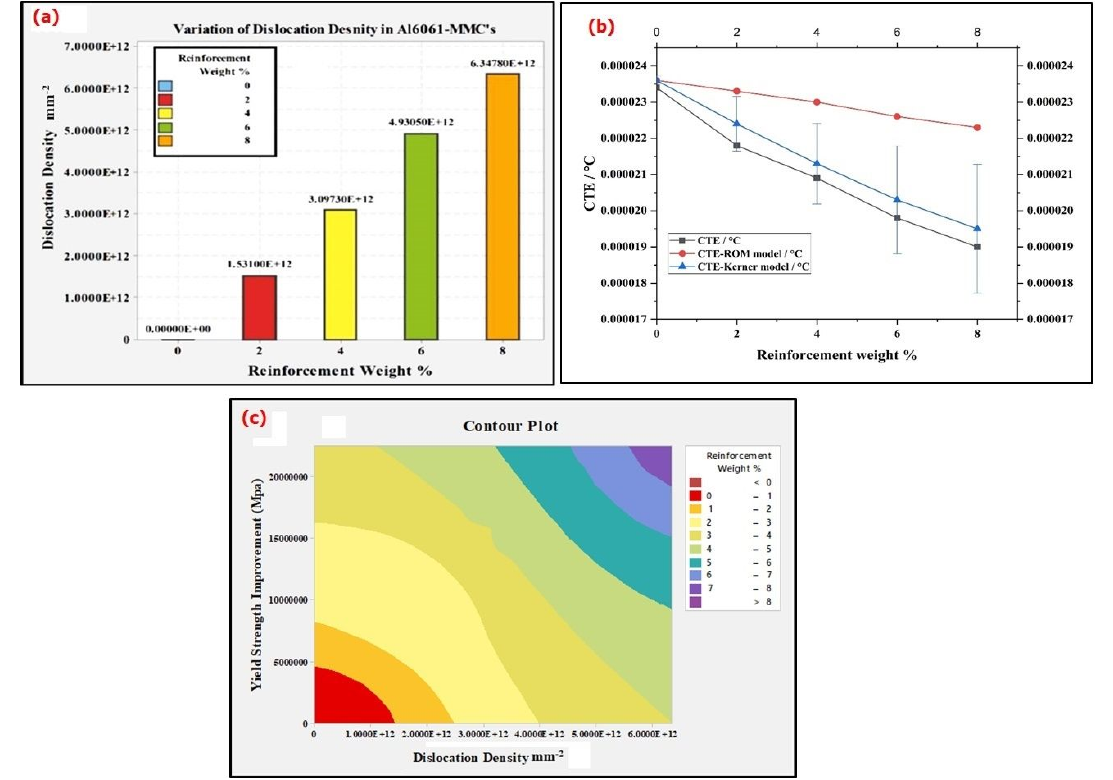
Figure 6. ( a ) dislocation density variation; ( b ) line plot of experimental CTE, Kerner model CTE, and ROM model CTE; and ( c ) variation of yield strength vs. dislocation density of various Al6061-TiC MMC samples.